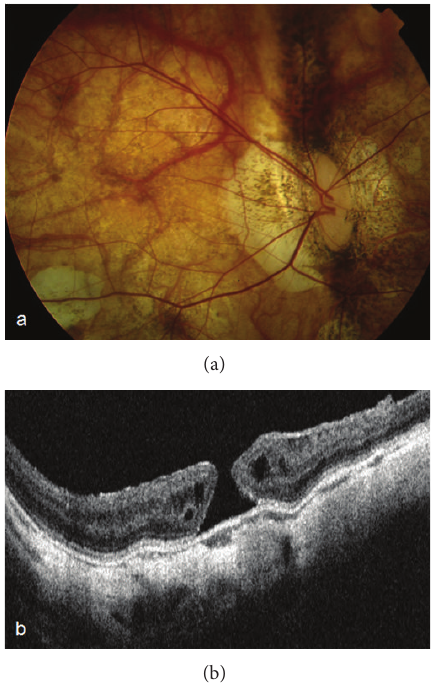
Figure 1: Ophthalmoscopy of the right eye shows a well-defined round foveal area that was slightly elevated with respect to the perifoveal retina (a). SD-OCT establishes a full-thickness macular hole with elevated edges of the lesion, a small accumulation of intraretinal fluid in the perilesional area, and no subretinal fluid cuff (b).